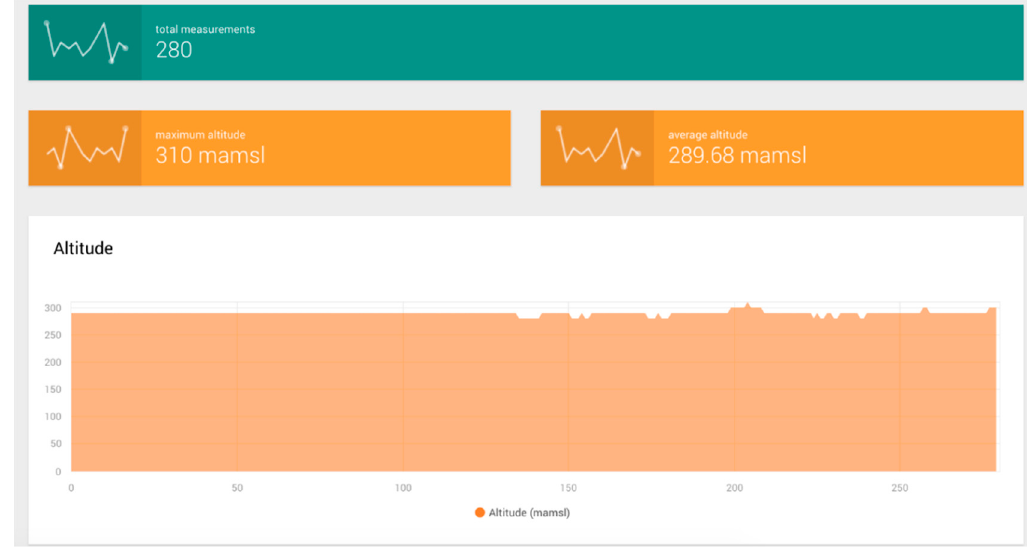
Figure 23. Mobile node altitude-related data. Table 2. Summary of drifter retrieved